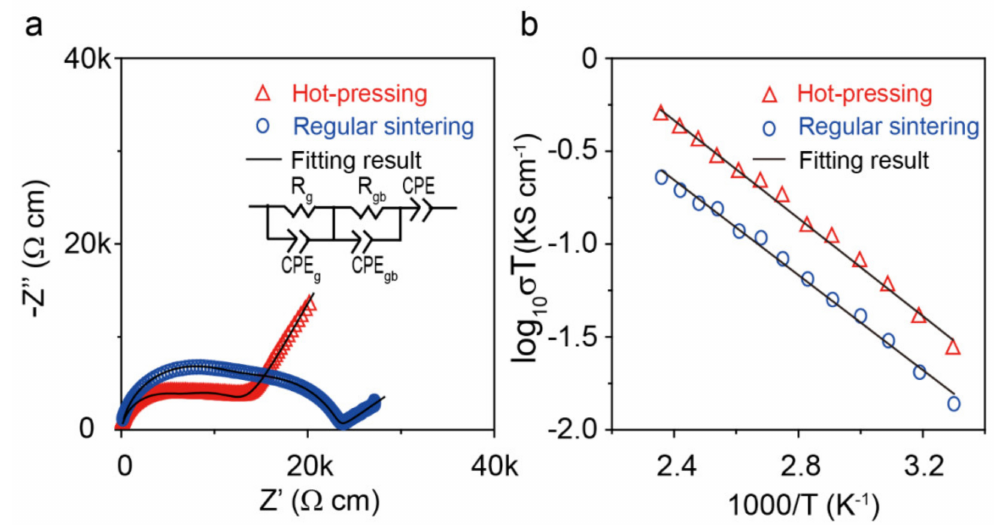
Figure 3. ( a ) Li-ion conductivities of LY 0.1 ZP at room temperature. The applied frequency was 110 MHz–40 Hz. and ( b ) Arrhenius plots of LY 0.1 ZP prepared by regular sintering and hot-pressing; the Arrhenius plots are based on the total impedances of the